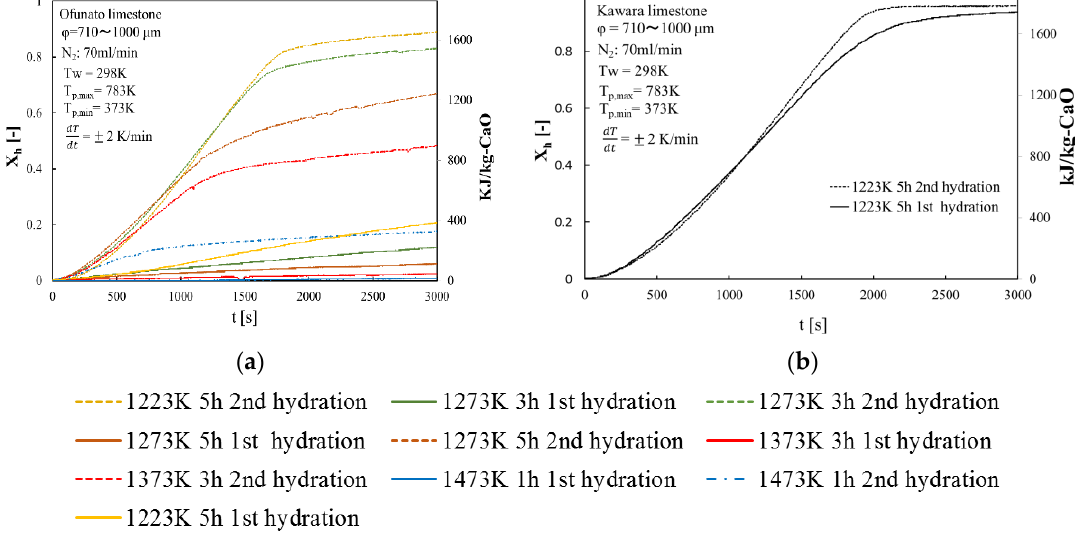
Figure 7. Hydration conversion ( a ) Ofunato CaO ( b ) Kawara CaO.